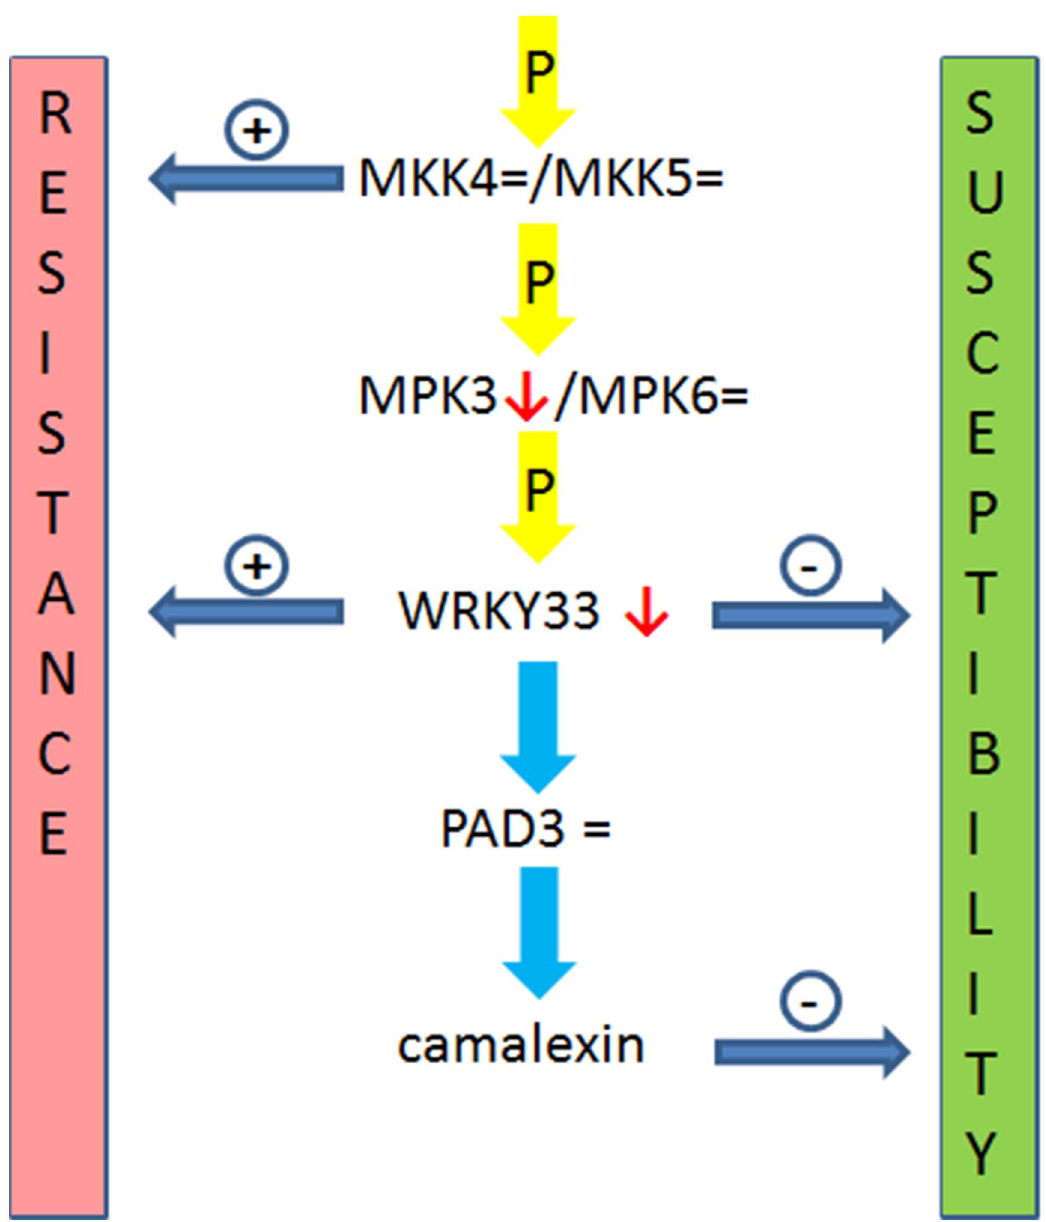
Figure 10. The WRKY33 pathway leading to camalexin as related to H.schachtii infection. The phosphorylation cascade involving WRKY33 leading to camalexin. P, phosphorylation. Q indicates that the expression of the gene is downregulated in syncytia induced by H. schachtii as compared to control root segments while=indicates no change in expression according to data from Szakasits et al. (2009). + and – indicate that increase or decrease leads to enhanced resistance or susceptibility,